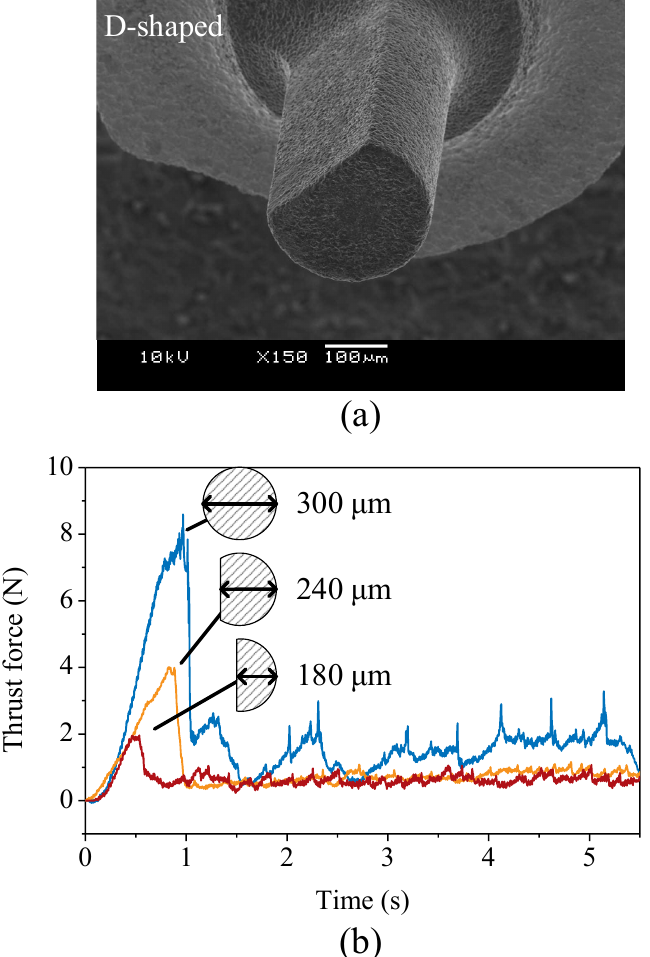
Figure 4. ( a ) A SEM image of a D-shaped tool and ( b ) thrust forces according to tool shapes (drilling conditions: axial feedrate 10 µ m/s; rotational speed of 50,000